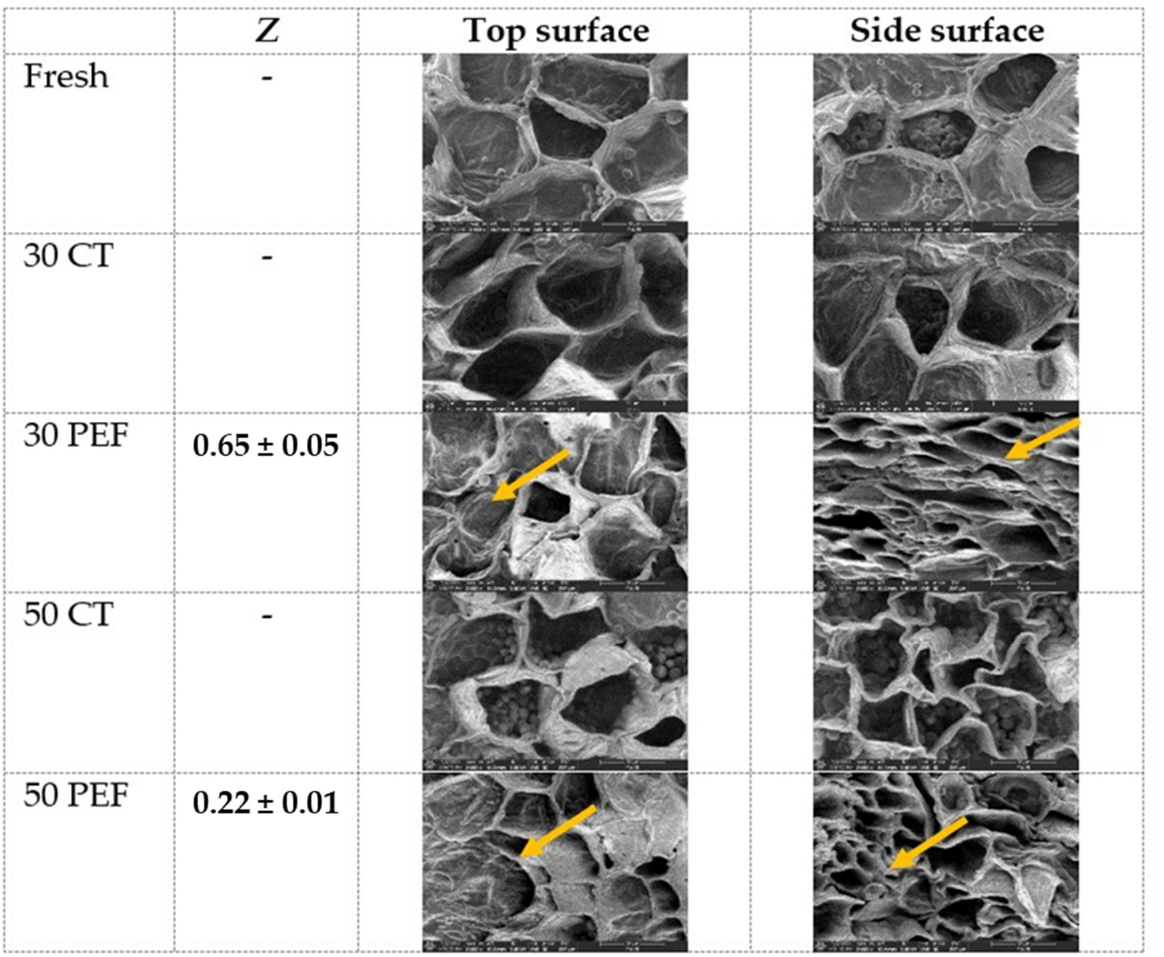
Figure 4. SEM images of the top and side surfaces of the fresh mango, conventionally pickled mango, and PEF-assisted pickled mango in both the 30 and 50 °Brix sucrose solutions (×2000). Yellow arrows show the disintegrated cell area.